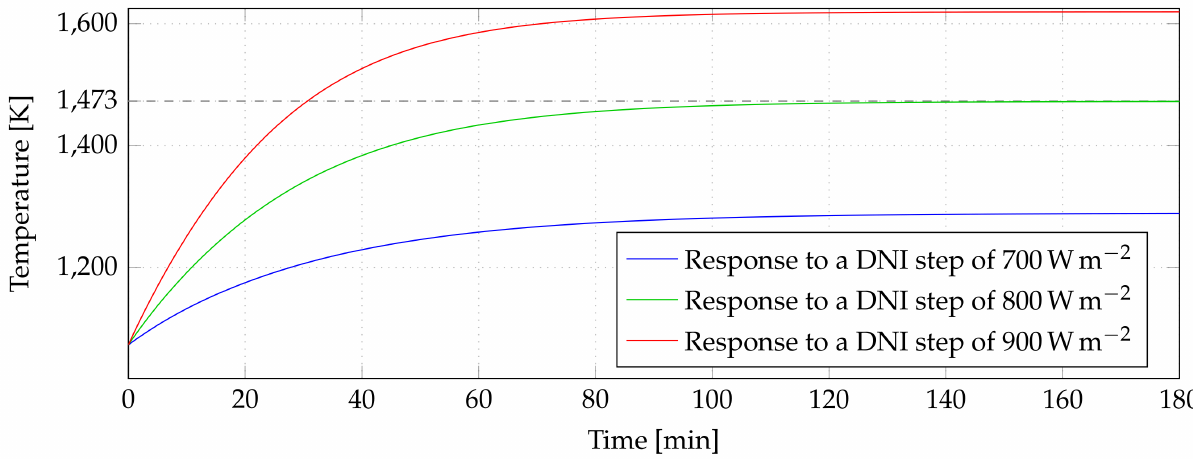
Figure 2. Evolution of the reactor’s temperature in response to various DNI steps (the biomass flow rate is set to f in = 1.465 th − 1 and the initial temperature is 1073 biomass